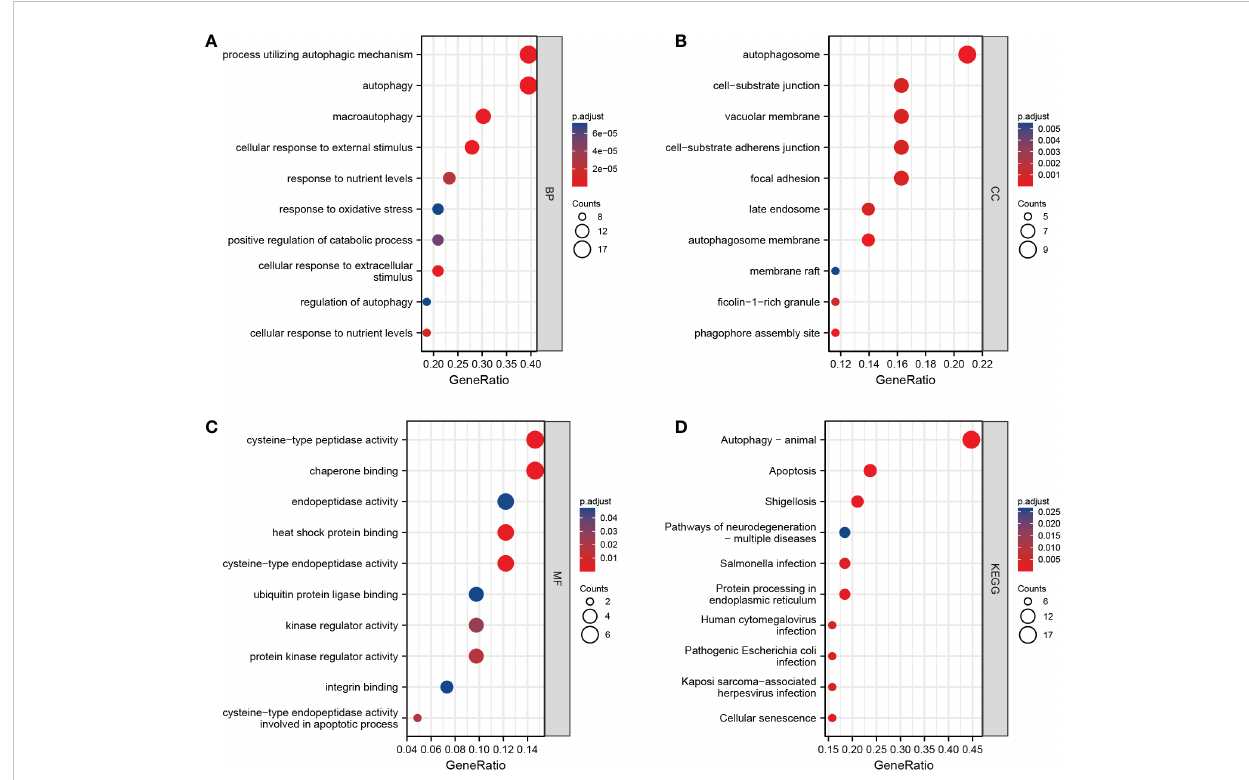
FIGURE 4 Results of enrichment analysis. (A – C) : Biological process, cellular component, and molecular function enrichment results for autophagy-related differentially expressed genes (ARDEGs). (D) : Kyoto Encyclopedia of Genes and Genomes (KEGG) enrichment results for ARDEGs. The abscissa is the number of enriched genes (gene ratio), and the ordinate is the Gene Ontology/KEGG terms.